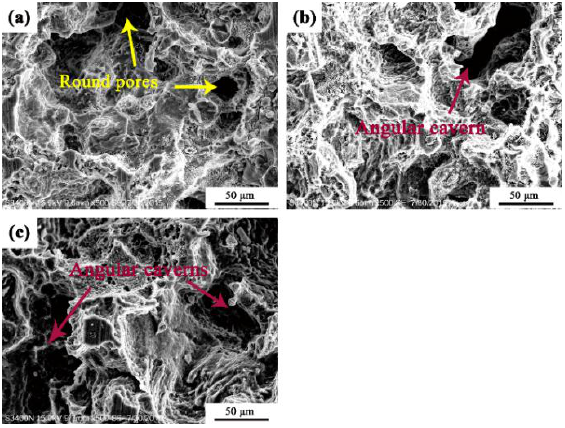
Figure 10. Corroded morphologies of AZI1.0 alloys at different discharge current densities after removing the products: 10 mA·cm −2 , 20 h ( a ), 100 mA·cm −2 , 2 h ( b ) and 200 mA·cm −2 , 1 h ( c ).